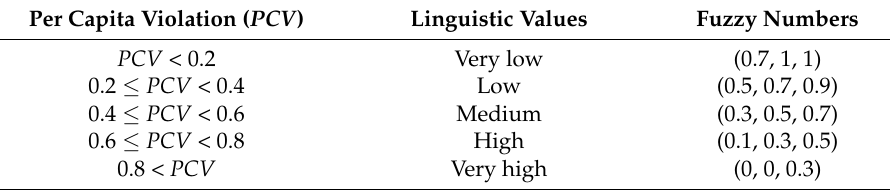
Table 5. Linguistic variables and the corresponding triangular fuzzy numbers for PCV.